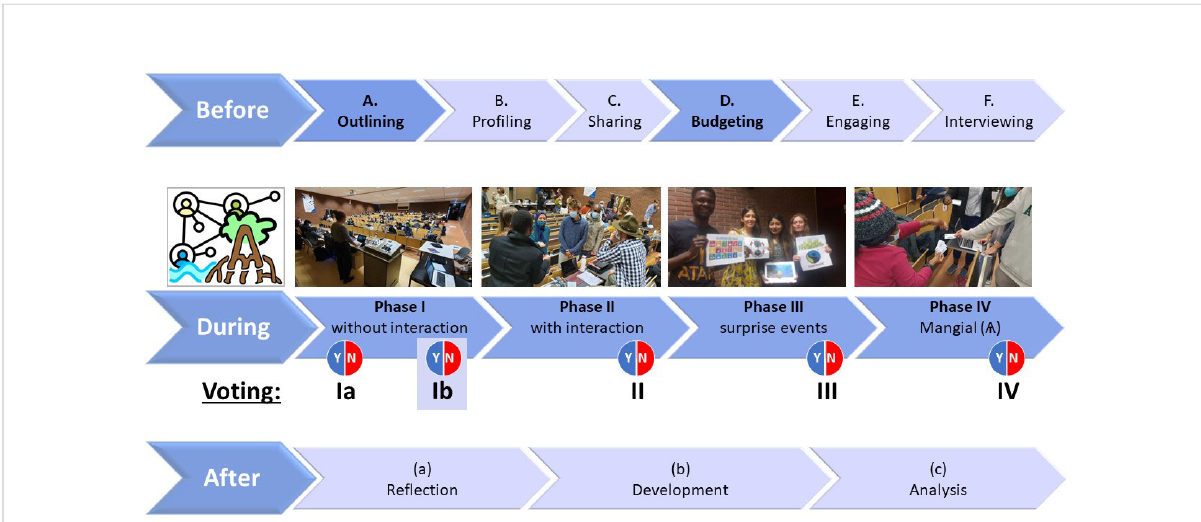
FIGURE 2 Flow-chart of the different stages before (6 steps: A, B, C, D, E and F), during (4 phases: I, II, III and IV with voting breaks indicated as Yes/No pie-charts) and after (3 debrie fi ng tasks: a, b and c) the Mangal Play. The stages in dark blue constitute a bare necessity to organise the Mangal Play without any preparation; its duration is expected to last ca. 5 hours. The stages in light blue are needed when there is time for preparation before and/or assessment after the Mangal Play, such as in a classroom setting. Preparation can be limited to anything between a few hours (when the Mangal Play is organised as a single-day workshop) and a few weeks (in an interactive course with a sequential build-up), whereas a posteriori assessment involves anything between 1 hour (workshop) to a few days (course). See Sections 3.2.1, 3.2.2 and 3.2.3 for